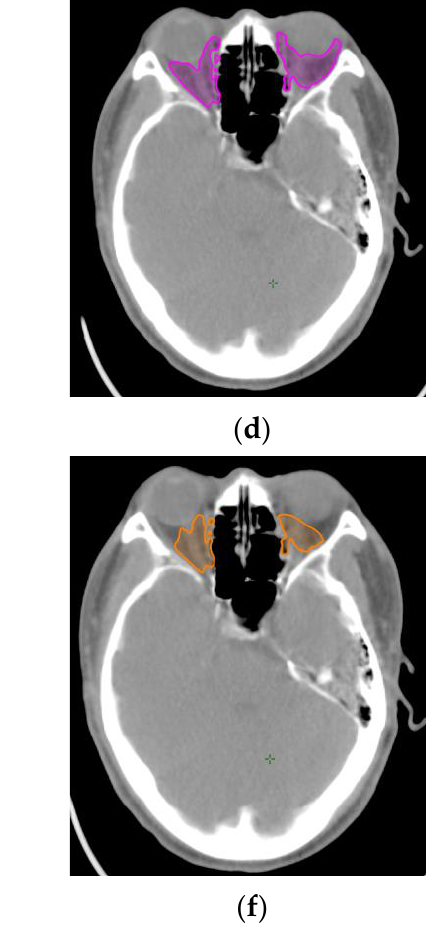
Figure 8. Image analyses of SUV-H EAT and SUV-H OAT. ( a ) EAT, with a specific HU between −190 and −10 , is shown in green in the CT images. ( b ) SUV ≥ 1.5 is defined as a high SUV. Regions of SUV ≥ 1.5 are contoured with black lines in the PET images. ( c ) The intersection of ( a ) and ( b ) is defined as SUV-H EAT and is demonstrated in blue. ( d ) OAT with a HU between − 190 and − 10 is outlined in pink. ( e ) Regions of SUV ≥ 1.5 are contoured with black lines. ( f ) The intersection of ( d , e ) is defined as SUV-H OAT and is outlined in orange. SUV-H EAT, high standardized uptake value epicardial adipose tissue; SUV-H OAT, high standardized uptake value orbital adipose tissue; PET/CT, positron emission tomography/computed tomography; HU, Hounsfield unit.